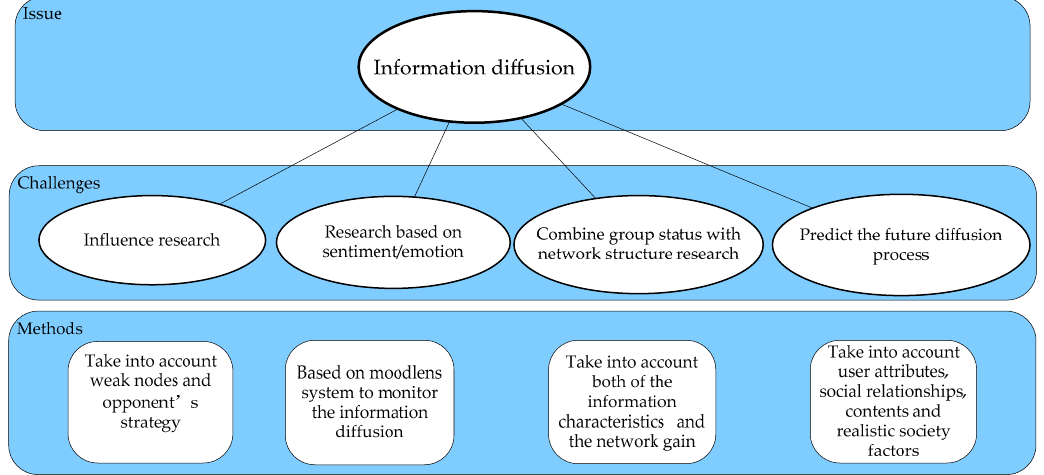
Figure 4. The Future Challenges and Methods for Information Diffusion